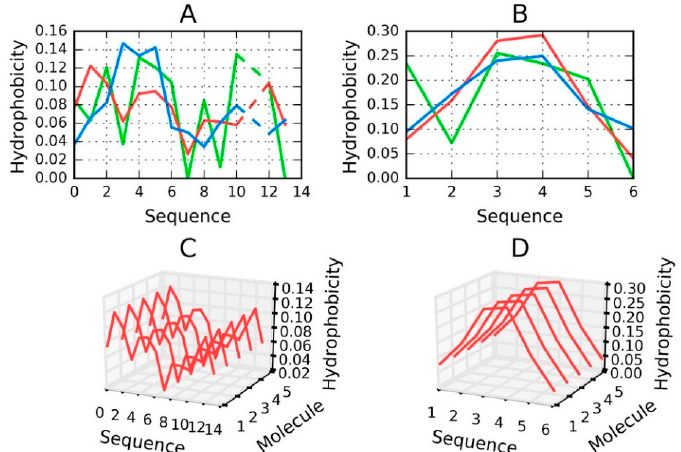
Figure 8. H (green), T (blue) and O (red) distributions for selected peptides: ( A ) Tau (305–311), ( B ) Tau (306–311B); ( C ) for ( A ) and ( D ) for ( B )—pseudo-3D view, presenting the observed hydrophobicity of a theorized structure of fibrillary tangles formed by linear propagation of the corresponding peptides. Dashed lines on ( A ) represent deleted residue number 11 Tau (305–311) according to data available in